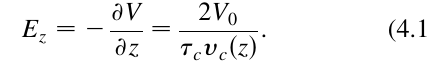
(cid:3) for W b bi